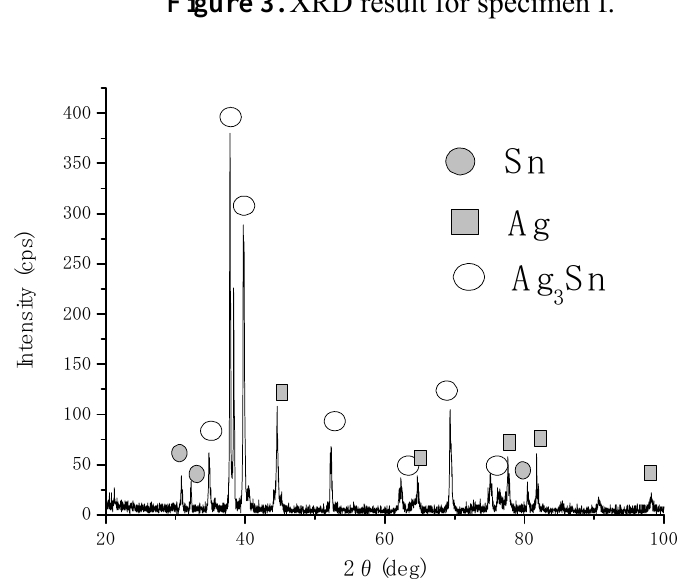
Figure 3. XRD result for specimen